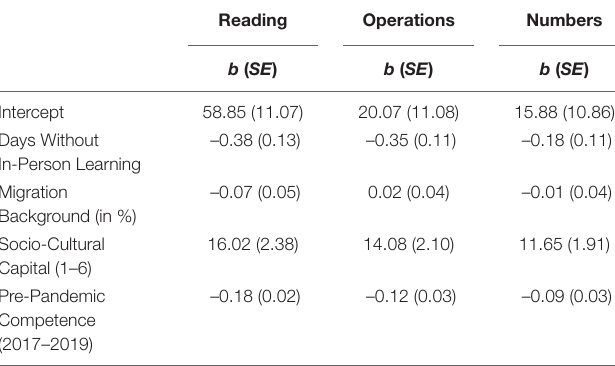
TABLE 5 | linear regressions of achievement change scores δ 2021 −− pre (2021 compared to the three pre-pandemic years 2017–2019) on length of school closure, school characteristics, and previous